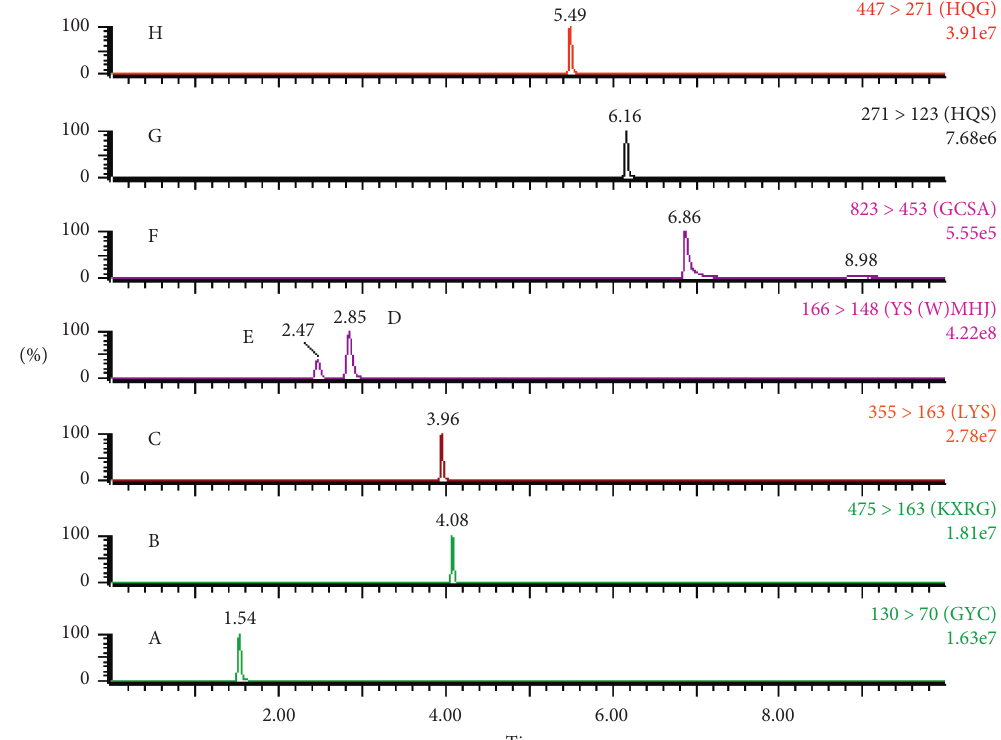
Figure 2: Typical UPLC-MS/MS analysis MRM chromatograms of the mixed standard solution: A (R, S)-goitrin, B amygdalin, C chlorogenic acid, D pseudoephedrine hydrochloride, E ephedrine hydrochloride, F ammonium glycyrrhizinate, G baicalein, and H